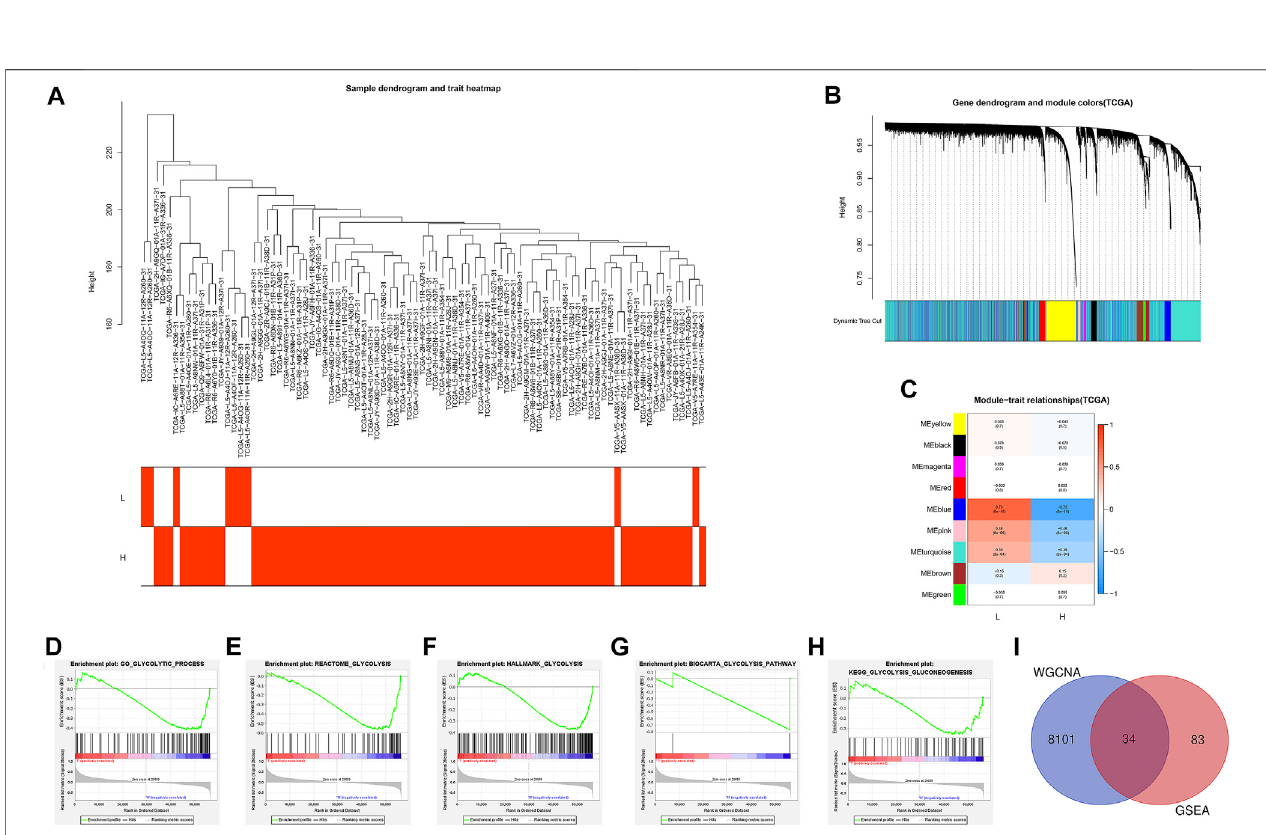
FIGURE 2 | Identi fi cation of the intersection genes. (A) 78 EAC sample clustering. All samples were clustered, and difference analysis was performed. (B) Gene dendrogramanddynamictreecuts.Eachcolorrepresentsamodule,andgeneswithsimilarexpressionpatternswillbeclassi fi edintothesamemodule. (C) Module-trait relationships.Everyrowrepresentsamoduleeigengene(ME).Theredmodulecorrespondstothesigni fi cantpositivecorrelation,andbluecorrespondstothesigni fi cant negative correlation. (D) GO glycolytic process gene set. (E) Reactome glycolysis gene set. (F) Hallmark glycolysis gene set. (G) Biocarta glycolysis pathway. (H) KEGG glycolysis gluconeogenesis. (I) Venn diagram shows the 34 IGs (intersection genes from WGCNA and GSEA). L: ESTIMATE low ; H: ESTIMATE high .